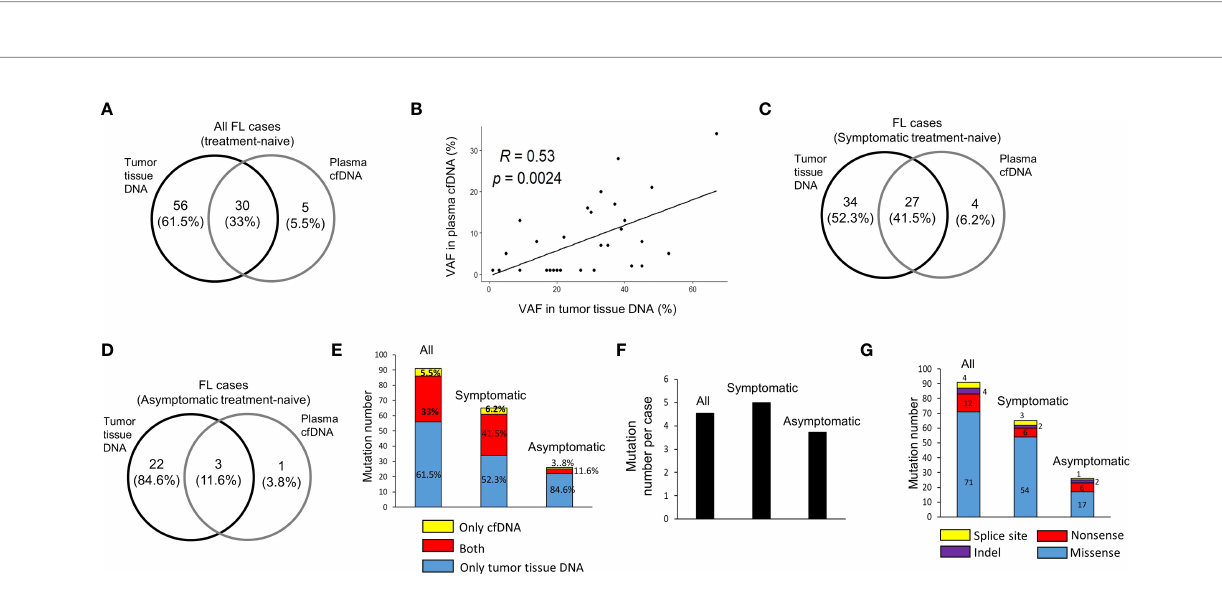
FIGURE 2 | Cancer-associated somatic variant numbers in DNA samples of FL patients. (A) The numbers of somatic mutations detected in plasma cfDNA and tumor tissue DNA for all FL patients shown as intersecting Venn diagrams. (B) Spearman correlation analysis between variant allele fractions (VAF) of mutations detected in both plasma cfDNA and tumor tissue DNA samples. The numbers and percentages of somatic mutations detected in plasma cfDNA and tumor tissue DNA for symptomatic (C) and asymptomatic (D) FL patients shown as intersecting Venn diagrams. (E) Bar graph of cancer-associated somatic mutation number per patient for all, symptomatic, or asymptomatic FL patients. (F) Bar graph of total numbers of somatic mutations detected in cfDNA and/or tumor tissue DNA for symptomatic and asymptomatic FL patients. (G) Bar graph of total number of somatic missense, nonsense, indel and splice site mutations detected in 13 symptomatic and 7 asymptomatic FL cases.